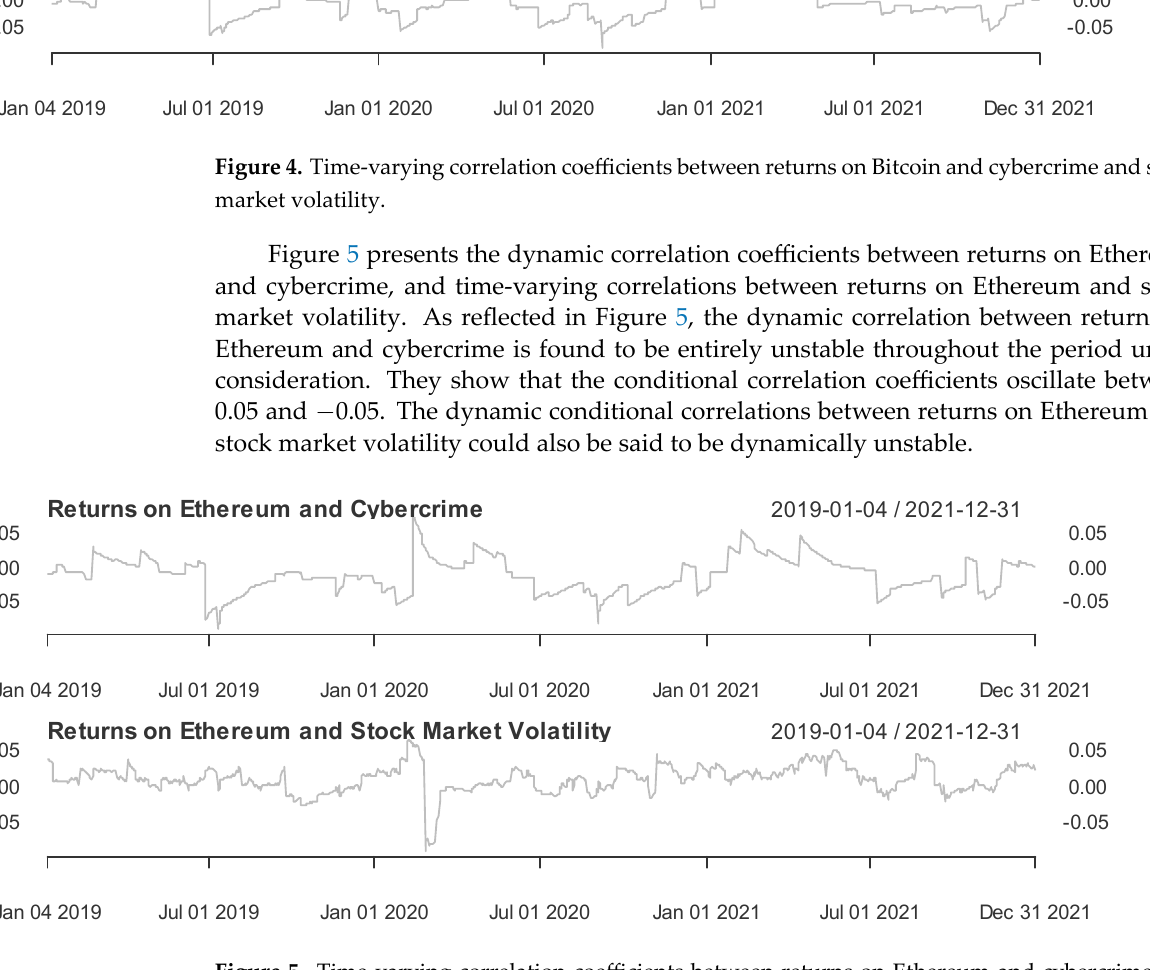
Figure 5. Time ‐ varying correlation coefficients between returns on Ethereum and cybercrime and stock market volatility.